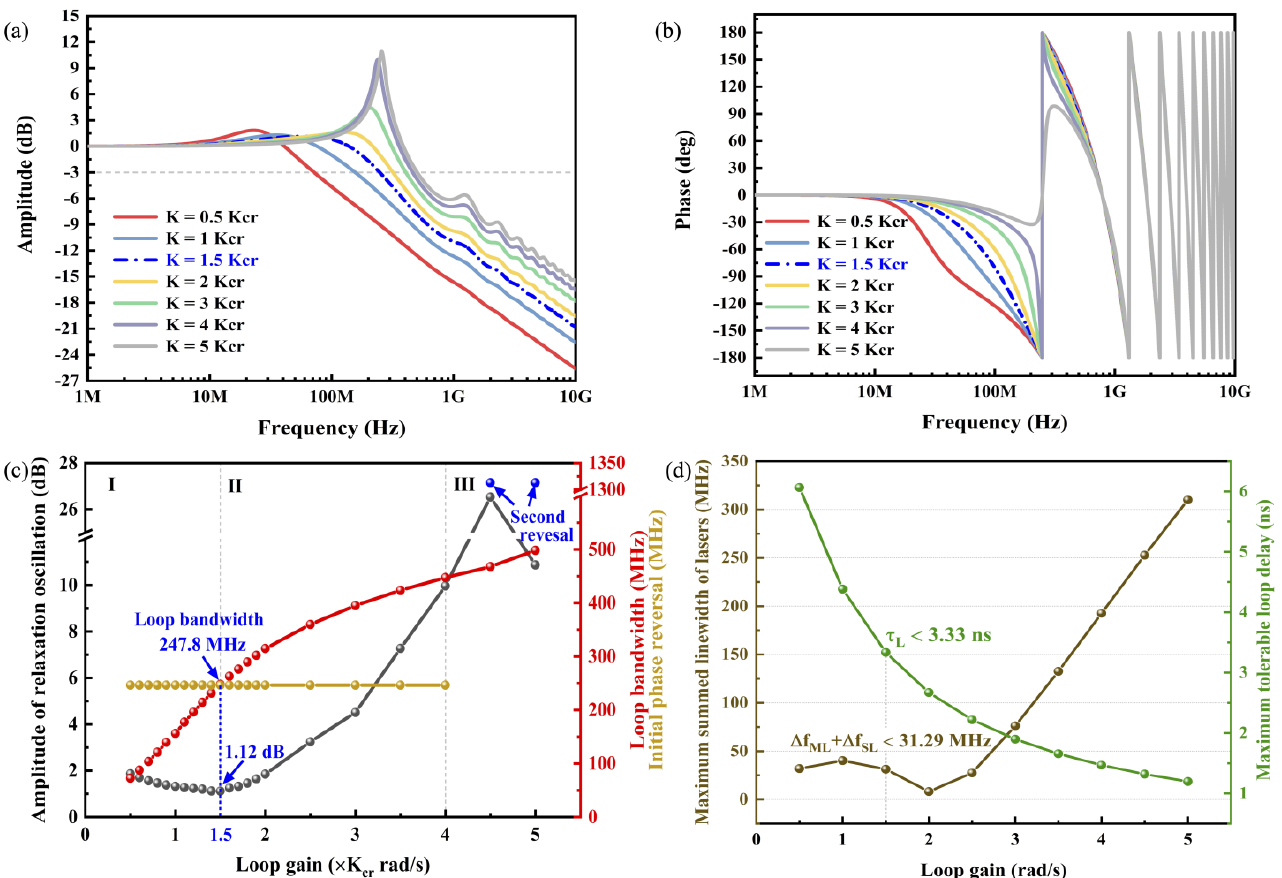
Figure 5. The effects of the loop gain on the loop bandwidth ( a ) the closed-loop amplitude-frequency response; ( b ) the closed-loop phase-frequency response; ( c ) the influence of the loop gain on the amplitude of relaxation oscillation, loop bandwidth, and initial phase reversal frequency point; ( d ) the influence of the loop gain on the maximum summed linewidth and the maximum tolerable loop delay.